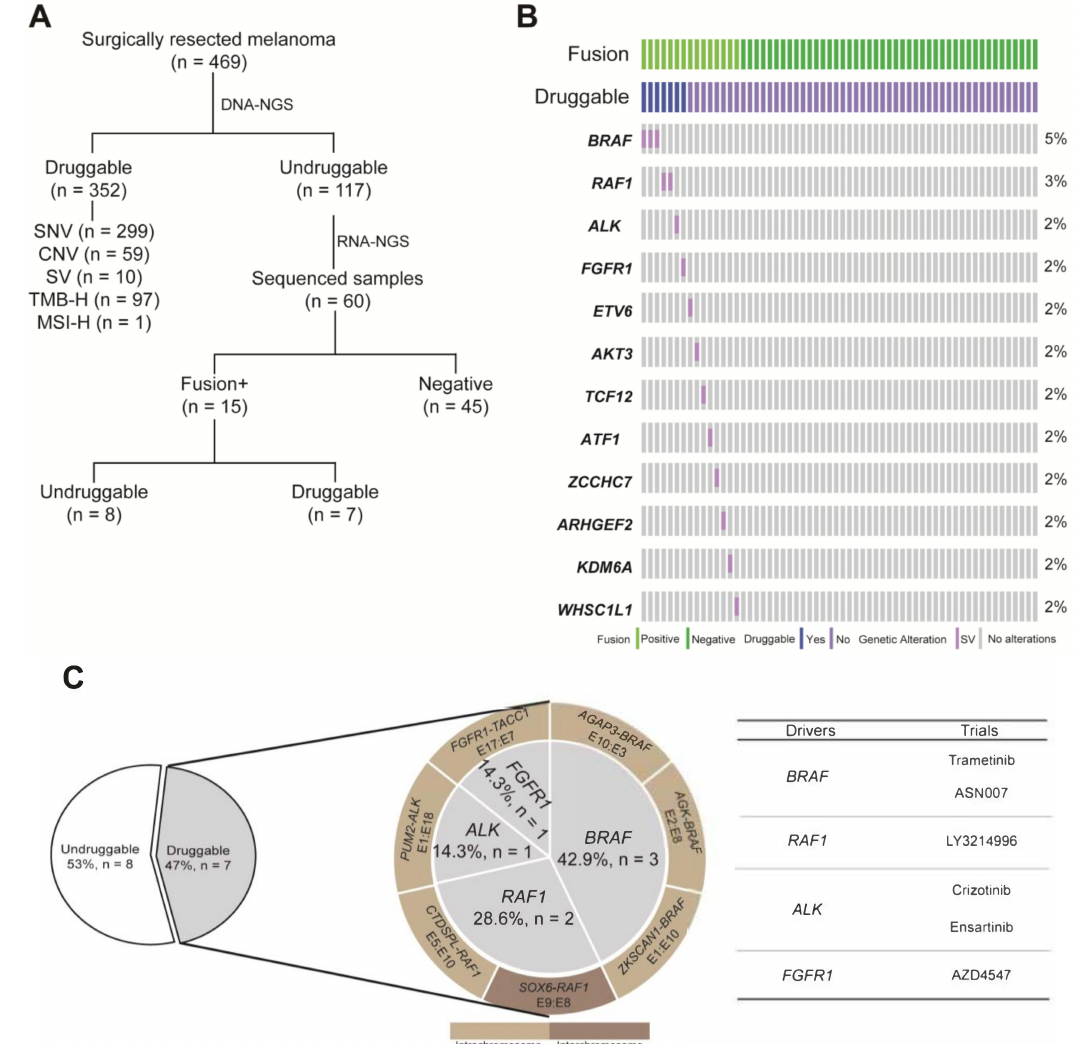
Figure 2. The fusion landscape of undruggable patients by RNA sequencing. ( A ) Description of the melanoma cohort by comprehensive DNA-seq and RNA-seq; ( B ) OncoPrint depicting fusions in the undruggable patients by Fusioncapture panel; and ( C ) pie chart summarizing the actionable fusions and matched therapy on